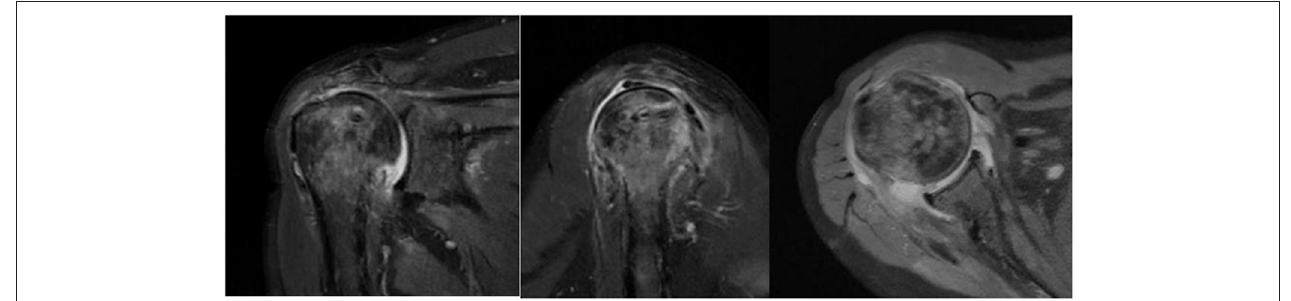
FIGURE 13 | Imaging data of patients with retear in the experimental